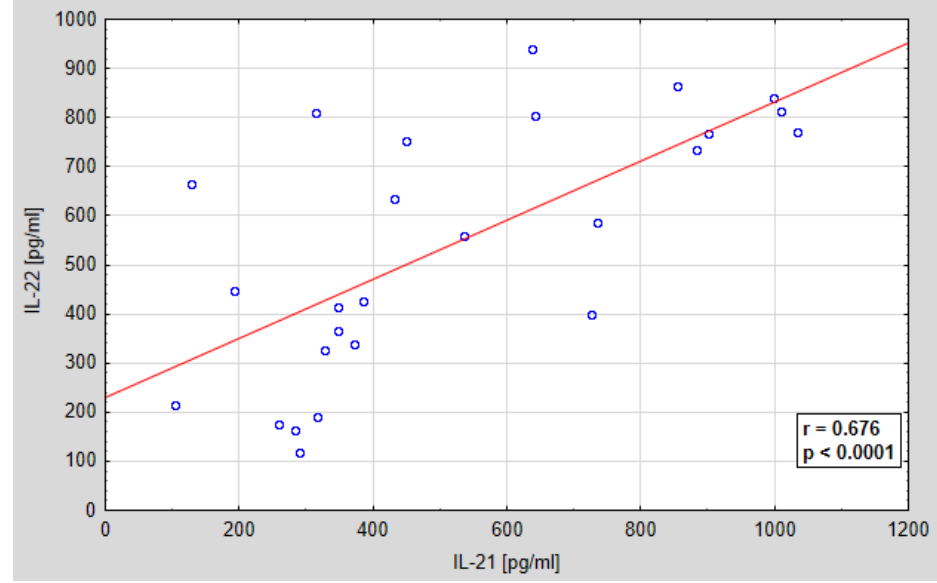
Figure 7. Linear regression curve showing the relationship between IL-21 and IL-22 levels in the serum of women with ovarian cancer; r -correlation coefficient, p -probability value.